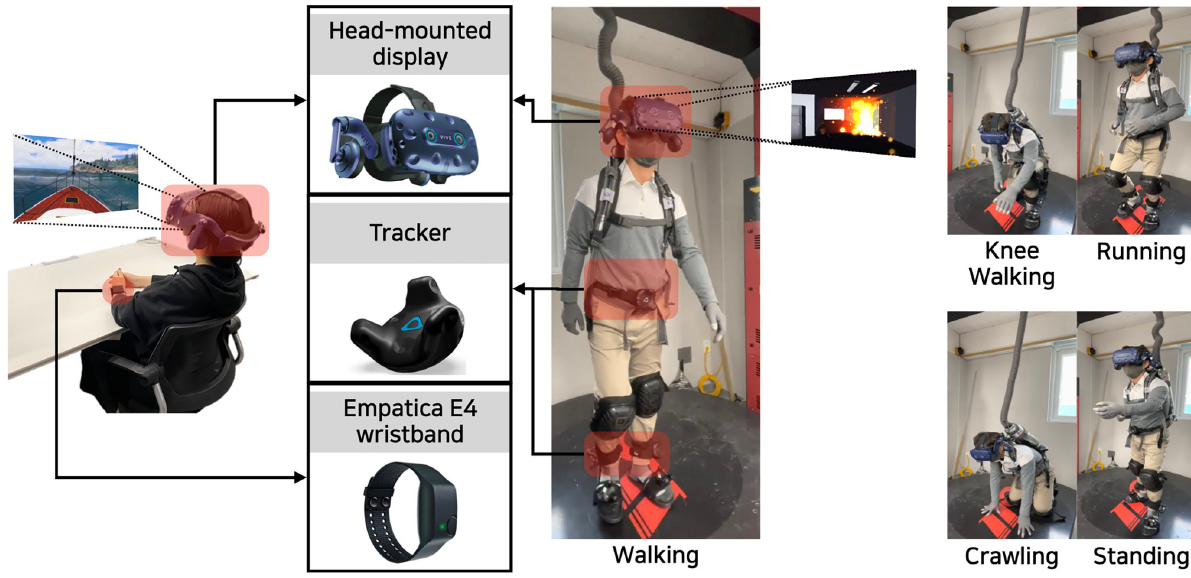
Fig 2. Data collection. Left: cybersickness study, Right: locomotion study.